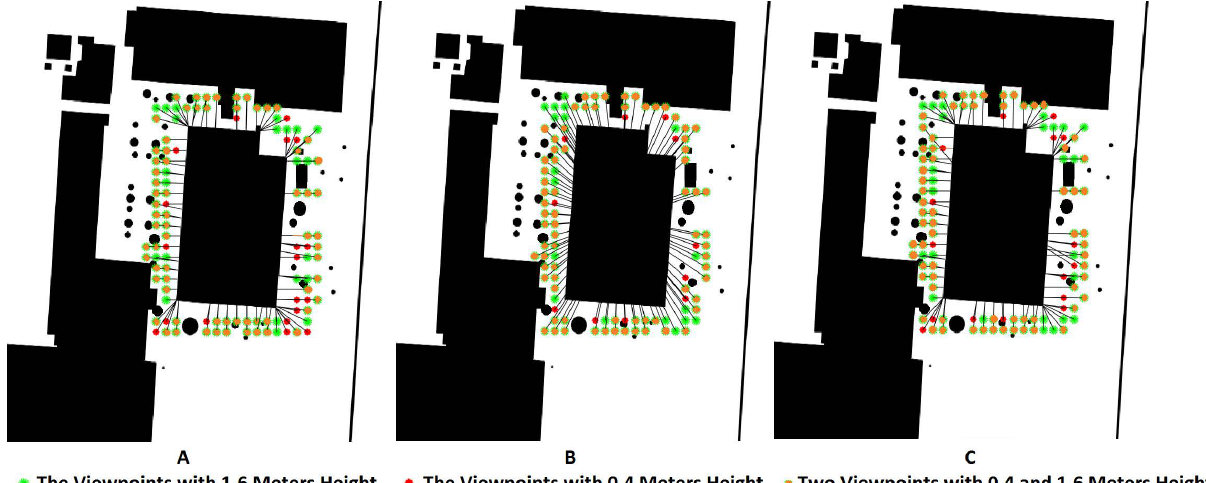
Figure 21. The final vantage viewpoints selected from the candidate viewpoints of the real-world project for the façade pointing ( A ), centre pointing ( B ), and hybrid ( C ) imaging